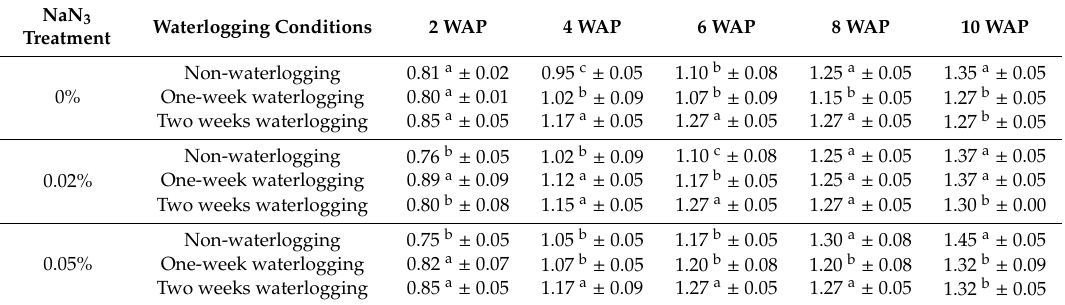
Table 2. Stem girth (cm) of okra plants grown from NaN 3 -treated seeds subjected to di ff erent waterlogging conditions four weeks after planting (WAP).